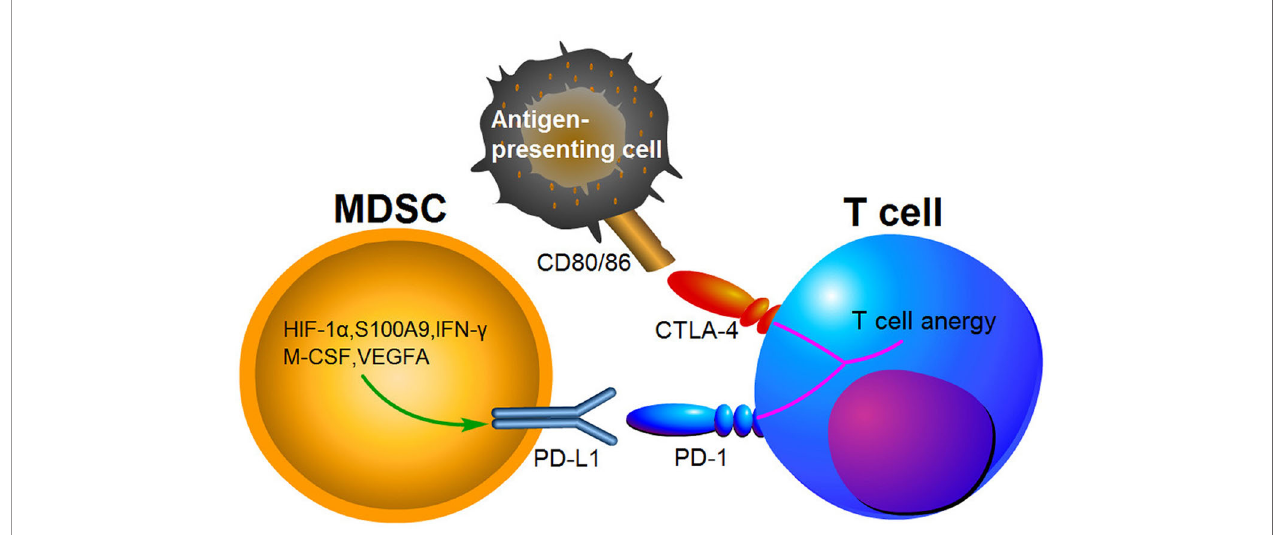
FIGURE 3 | The expression of PD-L1 in MDSCs causing T cell anergy via binding to its respective